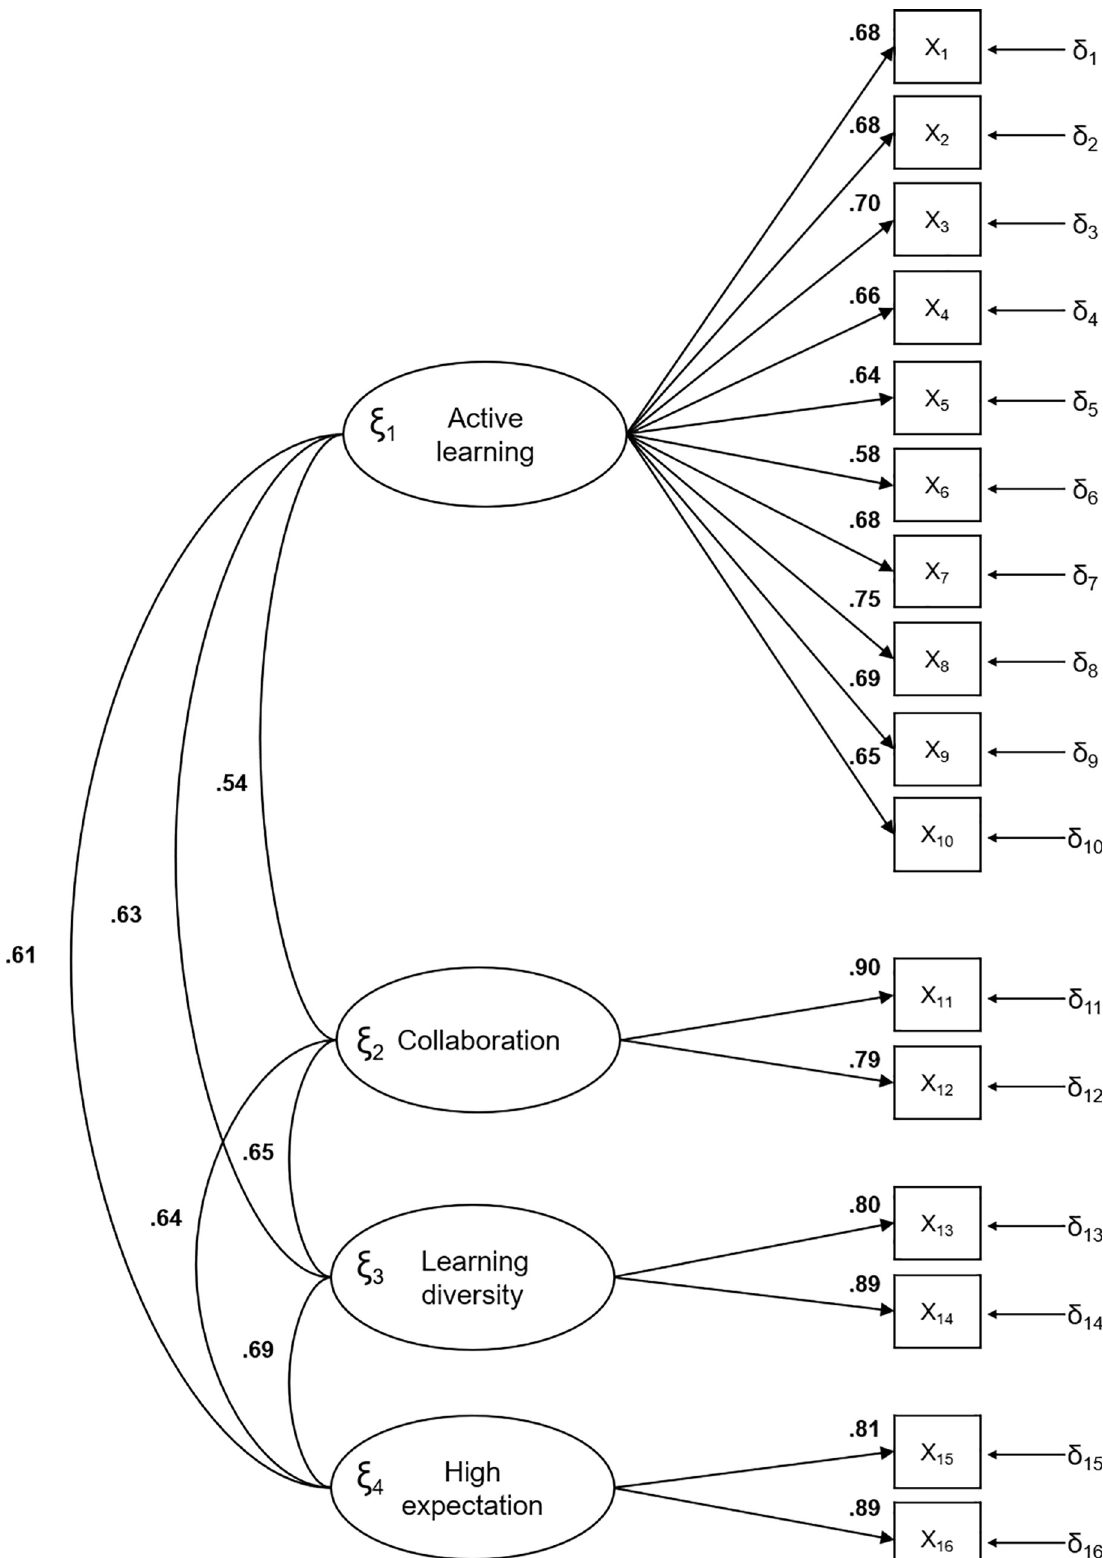
Fig 3. Standardized model parameters for the importance of educational best practices. https://doi.org/10.1371/journal.pone.0239014.g003 PLOS ONE | https://doi.org/10.1371/journal.pone.0239014 September 17,